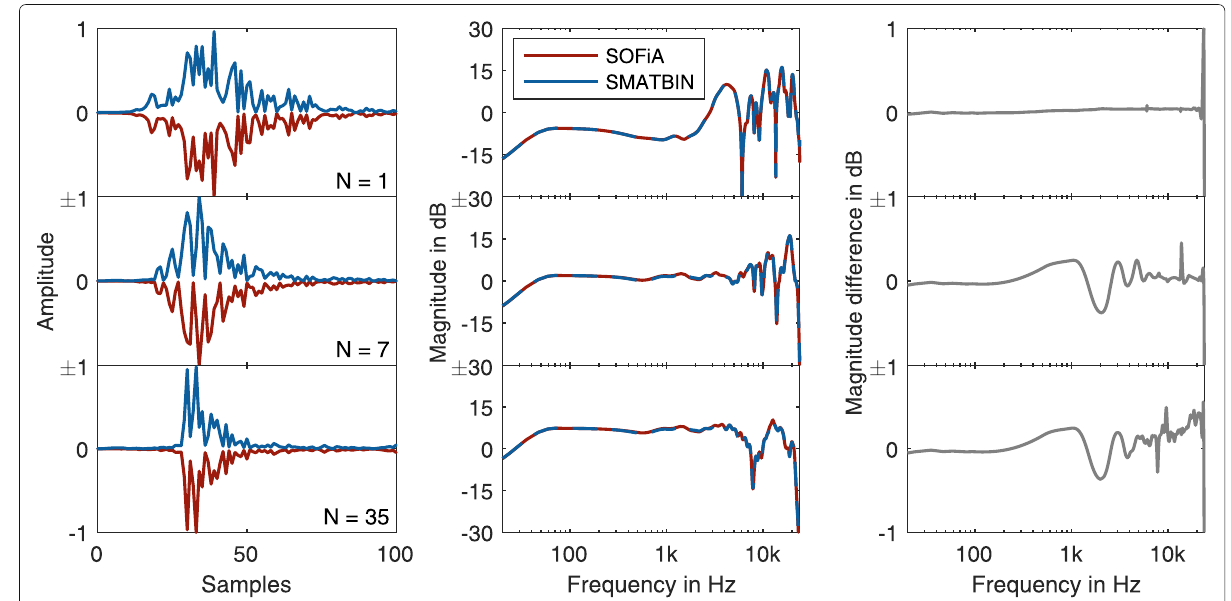
Fig. 2 Working Example 1: Left-ear BRIRs/BRTFs resulting from the SOFiA (reference) and the SMATBIN filter processing ( K = 2048 taps) for frontal head orientation ( φ = 0°, θ = 90°) and a single broadband plane wave incident from the front ( φ = 0°, θ = 90°) on three different rigid sphere arrays with Lebedev sampling schemes of orders N = { 1,7,35 } . For better illustration, the absolute amplitudes of the SOFiA BRIRs in the left column are inverted. The right column shows the magnitude differences between the SOFiA and the SMATBIN